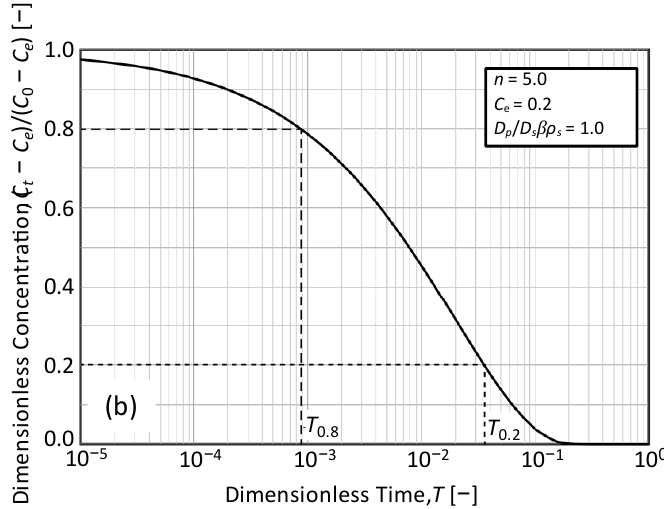
Figure 4. Typical numerical concentration decay curve. ( a ) Dimensionless concentration decay curve simulated based on parallel diffusion model, ( b ) reduced dimensionless concentration decay curve.